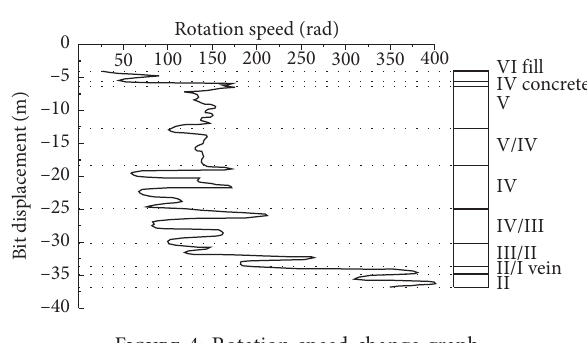
Figure 8: Torque change